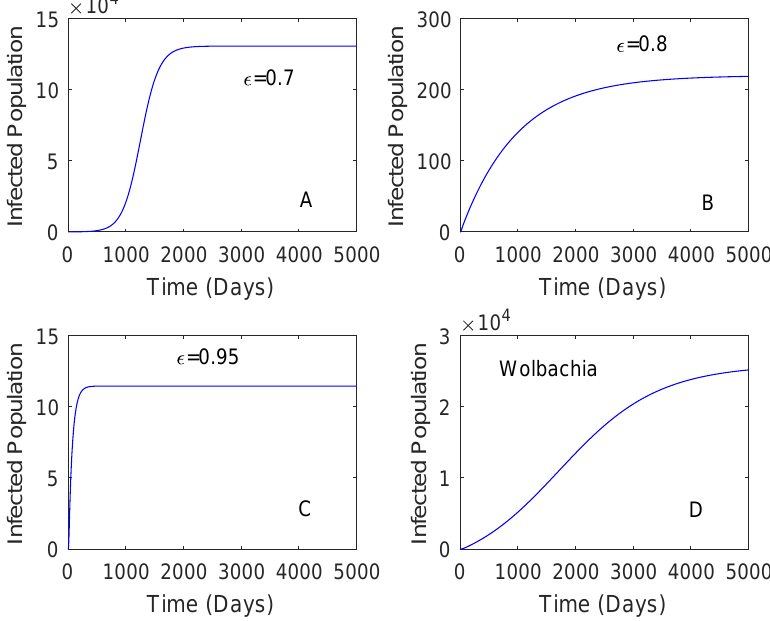
Figure 4. Comparing the performance of vaccination and Wolbachia with different vaccine efficacy. This is for the case R A = 2.91 and the vaccine rate is 0.5. The vaccine efficacy is 0.7 plot ( A ), 0.8 plot ( B ), 0.95 plot ( C ). The plot ( D ) is Wolbachia